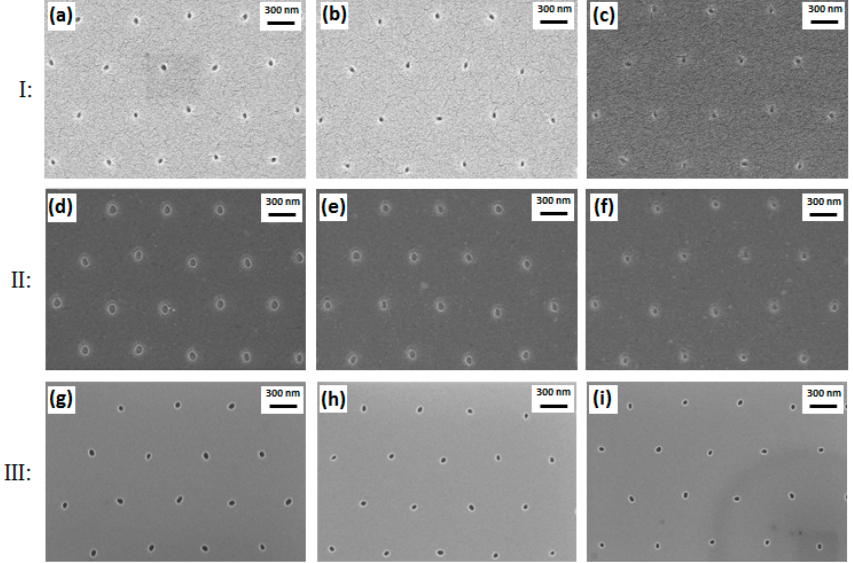
Figure 6. Top-view SEM images of nanoholes with different diameters resulting from corresponding